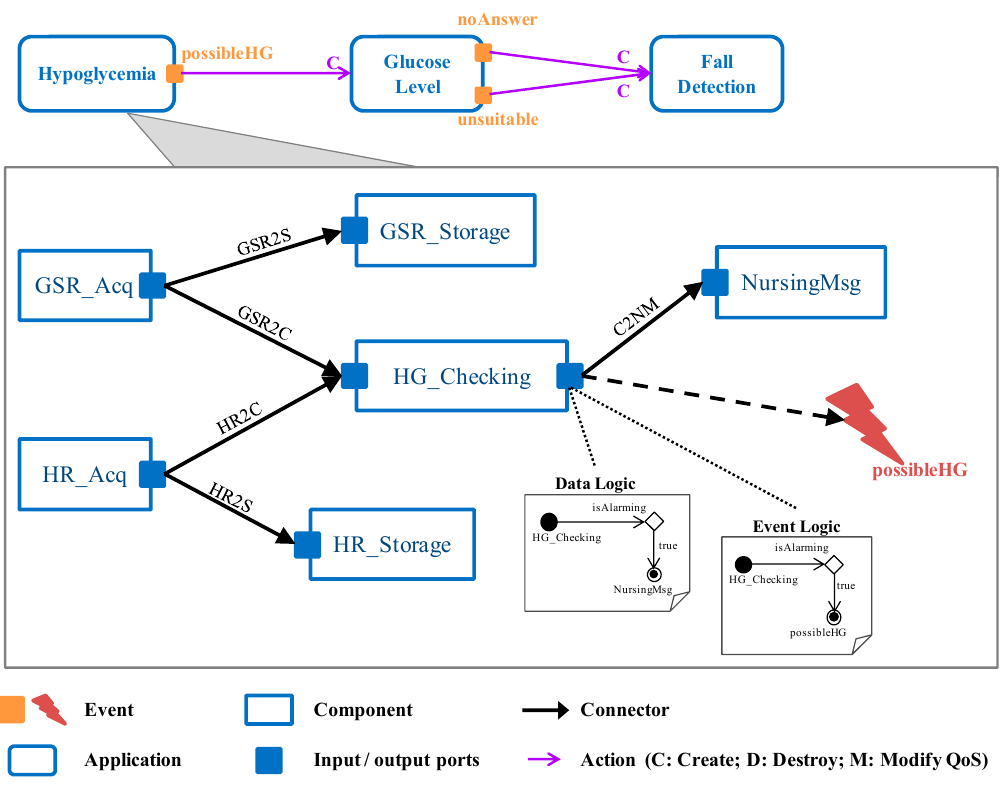
Figure 12 . Hypoglycemia prevention scenario. Figure 12. Hypoglycemia prevention scenario.